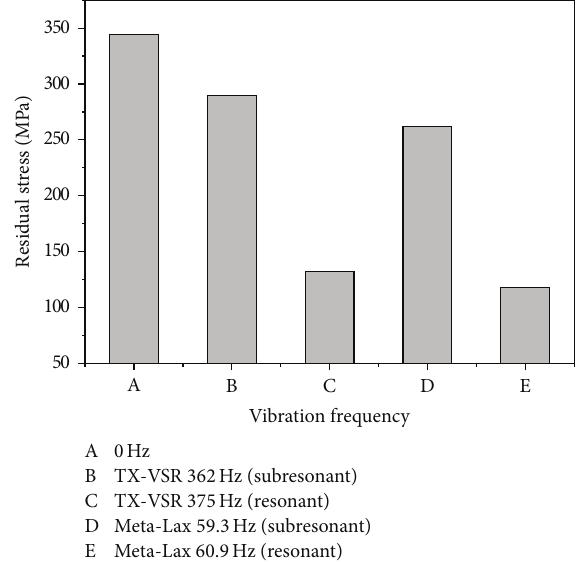
Figure 14: The relationship between the vibration frequency and the residual stress.